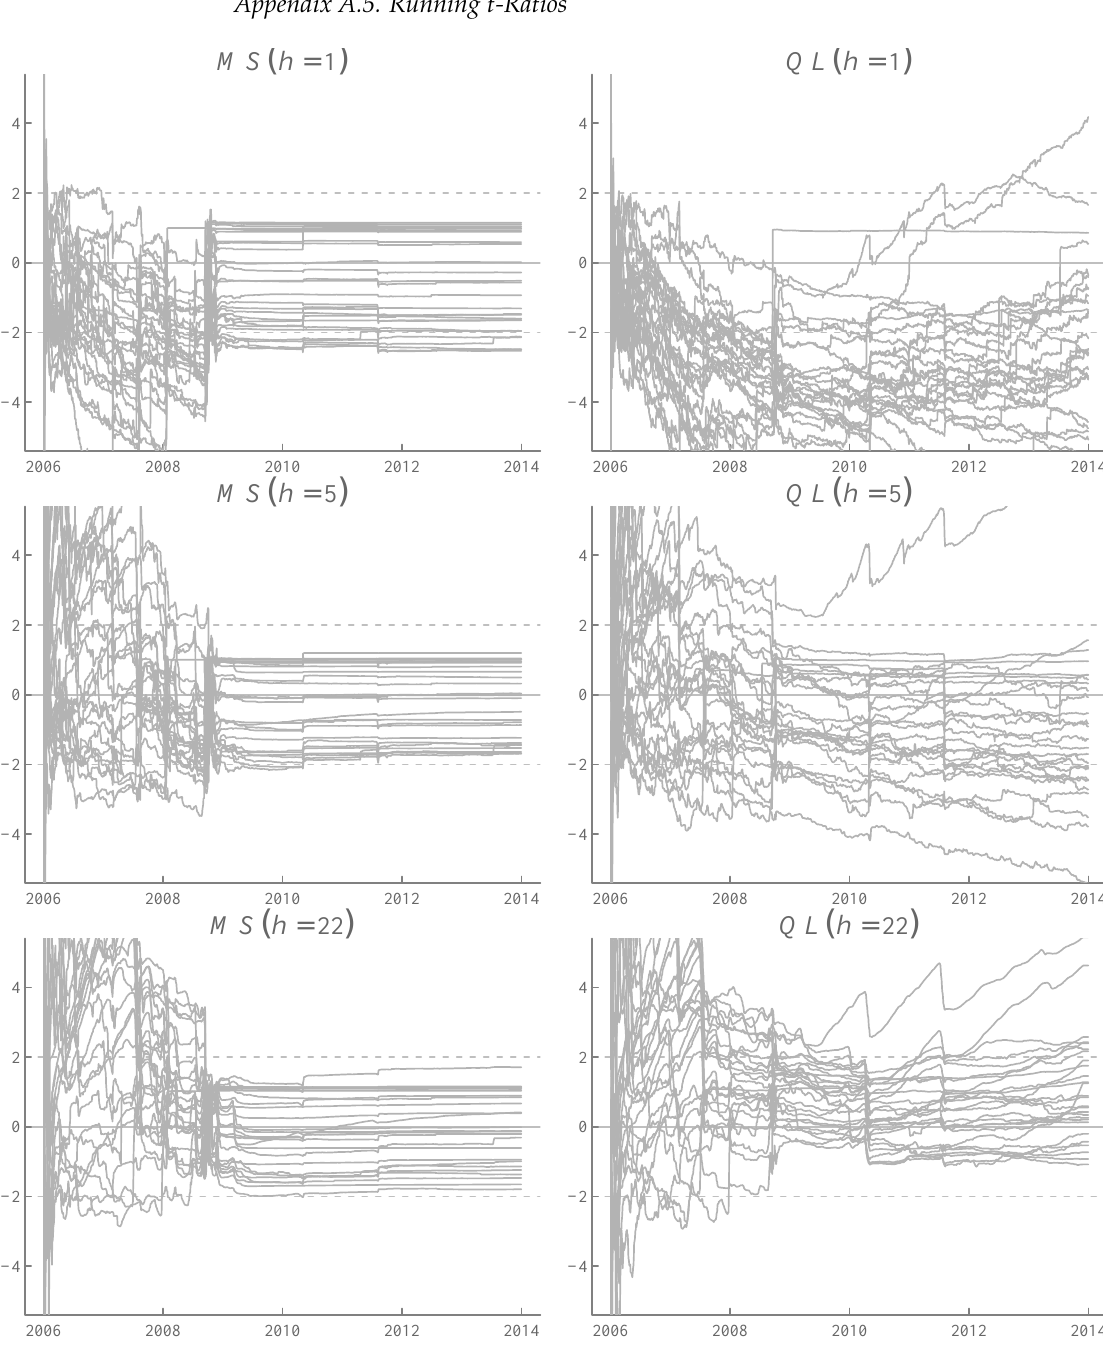
Figure A5. Running t -ratios of Diebold and Mariano [27] test of equal predictive accuracy of h -step RV rolling forecasts. Each panel has 27 lines for the 27 stocks in the sample. The baseline forecast is from the HARQ model (no transformation) and the comparison forecast is the exponential transform of the log forecast from model (Section 3.1) assuming log-normality. A positive value indicates better forecast from the comparison model against the baseline HARQ forecasts. MS for equality of mean squared error loss and QL for QLIKE loss of Patton [24]. The rolling forecasts are generated with a rolling estimation window of 8.67 years (104 months) followed by a one month prediction window shifted each month over 96 windows. The forecast sample is from 3 January 2006 to 31 December 2013 (2013 trading